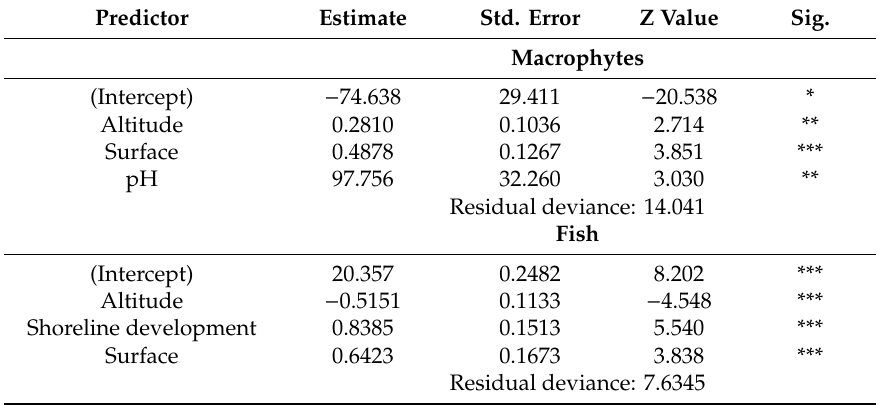
Table 2. GLM results with macrophyte and fish richness ( α -diversity) used as response variables. Predictor Estimate